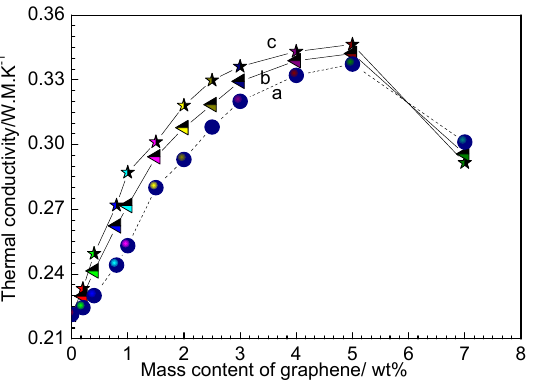
Figure 6. Relationship between thermal conductivity of RGO/NCC-TPU composite film and the mass content of RGO in the TPU initial concentration of 10 wt% (a), 20 wt% (b), and 30 wt% (c), respectively.